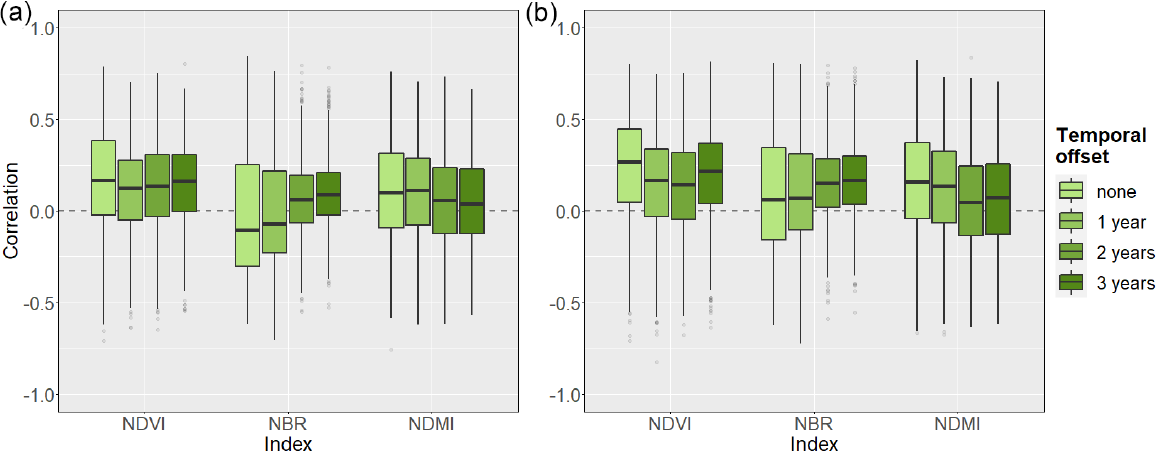
Figure 6. Boxplots of correlation scores between annual minimum scPDSI values and annual minimum ∆ Harmonics ( a ) as well as z-score ( b ) data. NDVI outperformed the other two indices for both ∆ Harmonics ( a ) and z-score ( b ) data. z-score generated overall slightly higher r